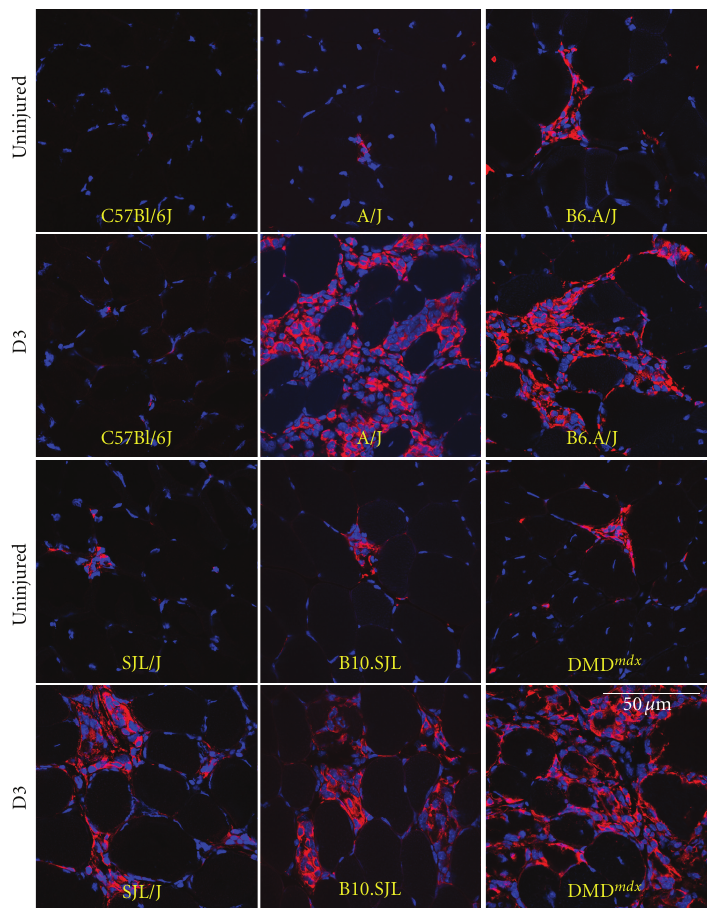
Figure 4: Macrophages (CD68+ cells) in muscle before and after injury. We labeled cross sections of uninjured and injured TA muscles with antibodies to CD68 to identify macrophages (red) and DAPI to mark nuclei (blue). Focal areas of macrophage infiltration were evident in uninjured muscle of all dysferlinopathic strains as well as DMD mdx mice. At D3 following LSI, macrophage numbers increased significantly in these mutant